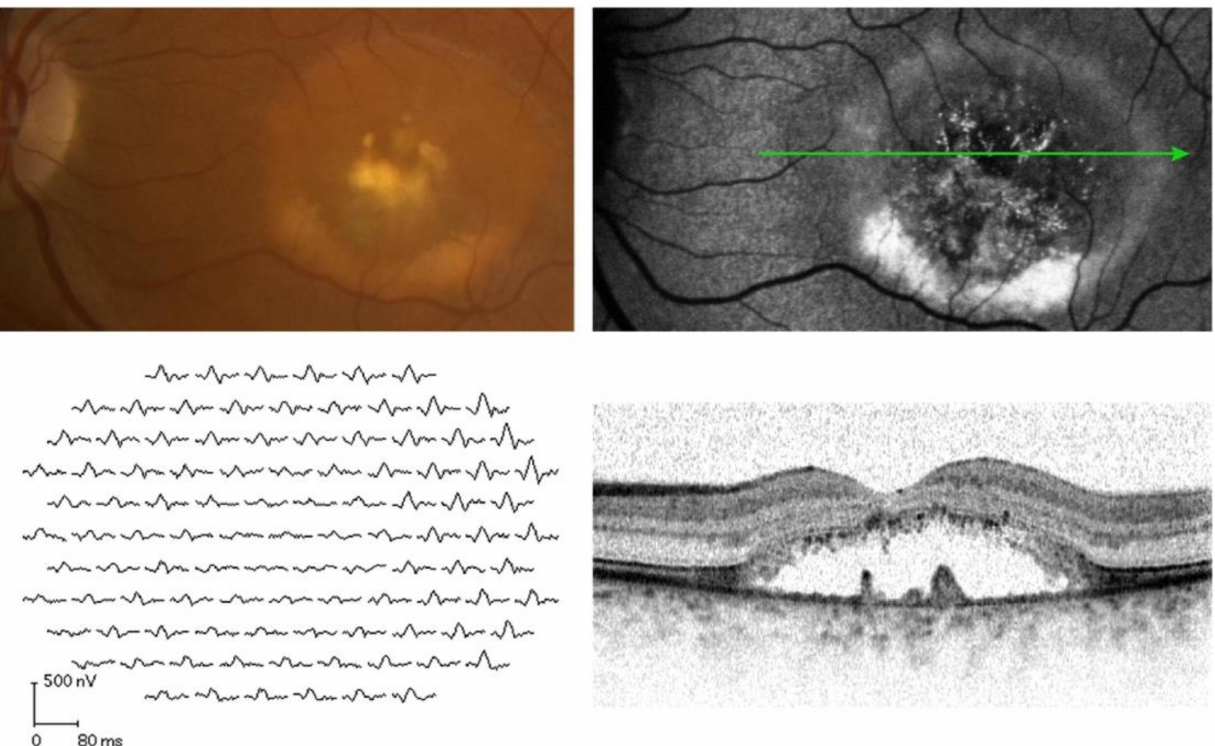
Figure 2. Morphologic and functional tests in a patient present with Best vitelliform dystrophy. ( Top left ): fundus image. ( Top right ): fundus autofluorescence with green arrow showing the direction of the OCT scan. ( Bottom left ): mfERG from the same patient. ( Bottom right ): OCT scan from the direction indicated by the green arrow as shown in ( top right ). The paracentral hyperautofluorescence in the image of fundus autofluorescence corresponds to the precipitate-like alterations on the outer surface of the photoreceptor outer segments. The hypoautofluorescence in the center of the lesion corresponds to atrophy and thinning of the outer nuclear layer in the OCT image. The focal paracentral accumulation on the retinal pigment epithelium/Bruch membrane shown in the fundus image and the image of fundus autofluorescence probably represents some degree of fibrosis. mfERG shows the significant reduction in amplitudes in the associated area (reused from Bitner et al. 2012 with permission